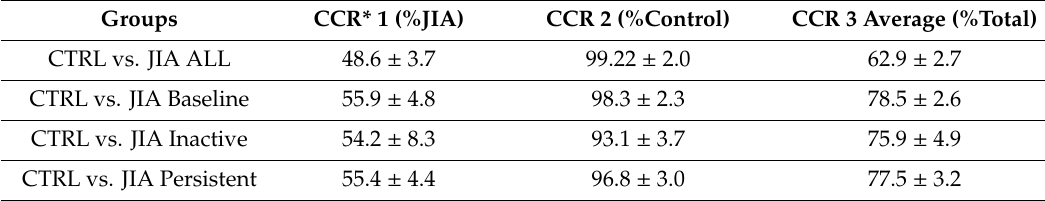
Table 2. PLS-DA models in DCV of volatile organic compounds (VOCs) data matrix.